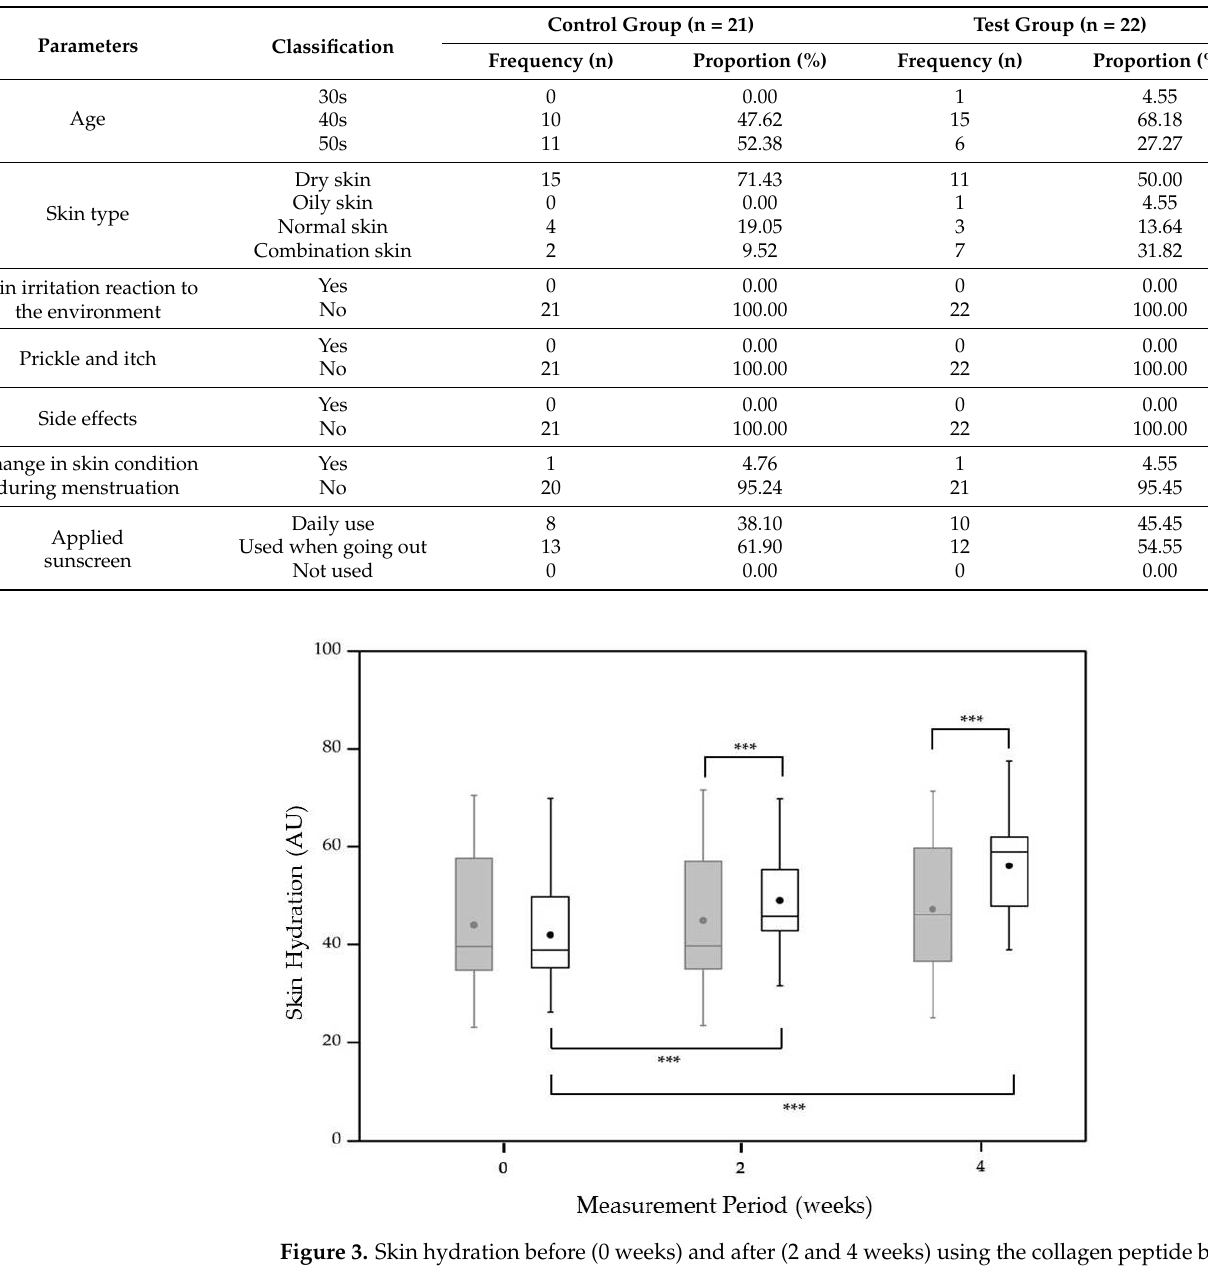
Figure 3. Skin hydration before (0 weeks) and after (2 and 4 weeks) using the collagen peptide buccal delivery film of the control group (gray) and test group (white). The boxplot shows the average (•), median ( ), and max–min whiskers ( I ). The changes were significantly different between the control and test groups, and before and after intake, with p < 0.001 (***).